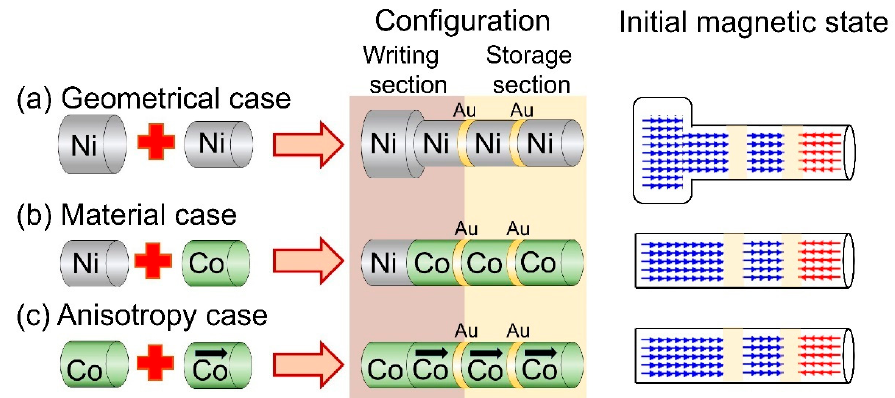
Figure 2. Scheme of the three different nanowires simulated during this work. Each nanowire is composed of a writing section (combining a soft and a hard magnetic segment) and a storage section (made of two hard magnetic segments). The hard magnetic segments are separated by non-magnetic Au layers with 20 nm in thickness (chemical constraints).